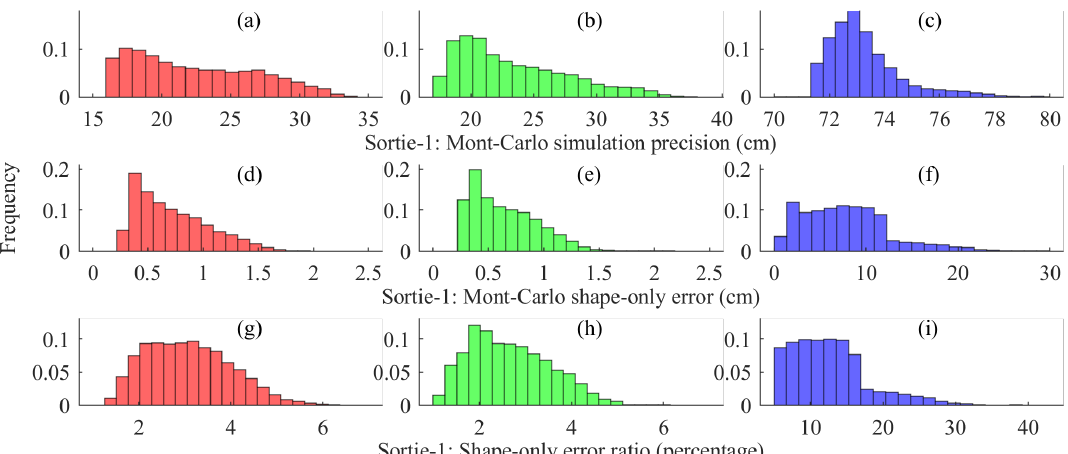
Figure 10. The 3D precision histogram of the sparse point cloud, based on Monte Carlo simulation. Sortie-1 was selected as an example. For spatial variability of all three sorties’ 3D precision, please refer to Figure 9. The first row, ( a – c ), are for whole precision from the Monte Carlo simulation; The second row, ( d – f ), are for shape-only errors, regardless of the exterior POS record or ground control. The third row, ( g – i ), are for the proportions of shape-only error, accounting for all precision. The first, second, and third columns are for the X , Y , and Z dimension,